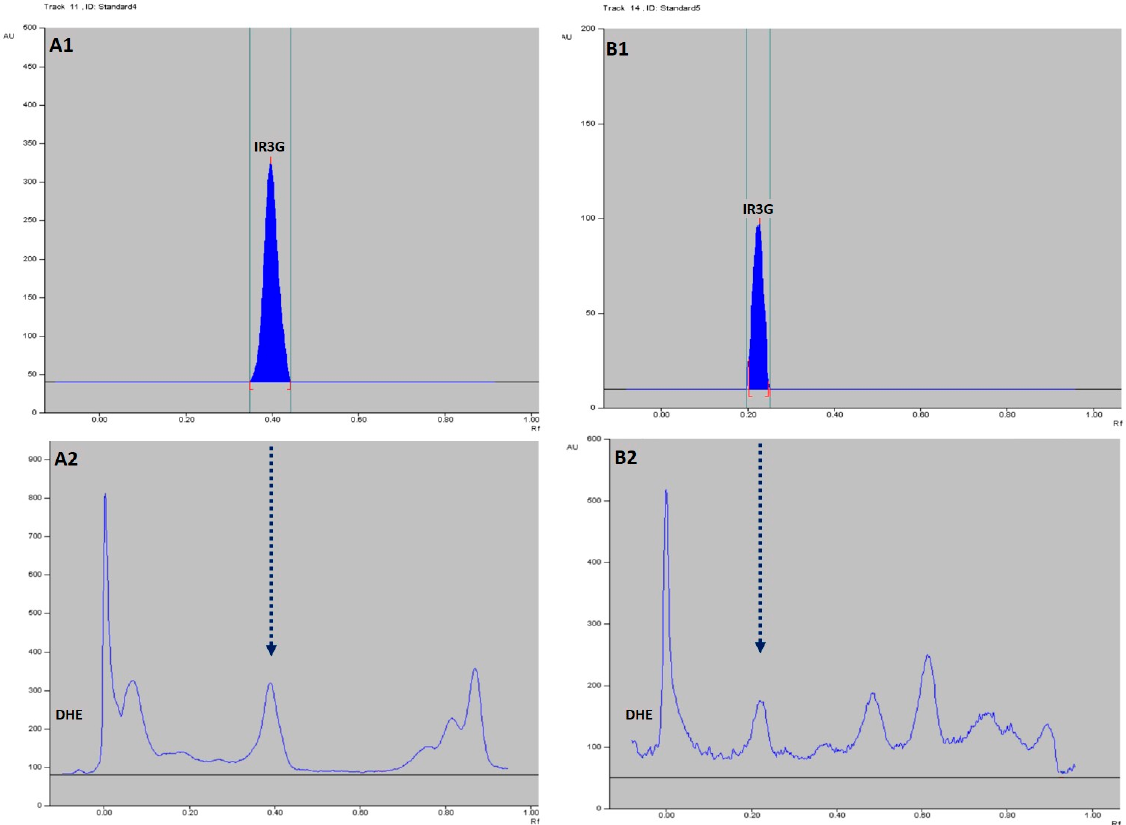
Figure 11. The chromatographic peaks of a standard IR3G and the extract DHE by NP ‐ ( A1 , A2 ) and RP ‐ HPTLC ( B1 , B2 ) at λ max 254 nm. The R f values of IR3G (100–400/500 ng, each n = 3) in NP ‐